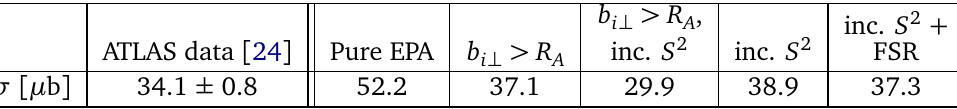
(cid:112) = 5.02 TeV. The muons are s NN > 10 GeV, p µµ < 2 GeV. The data µµ ⊥